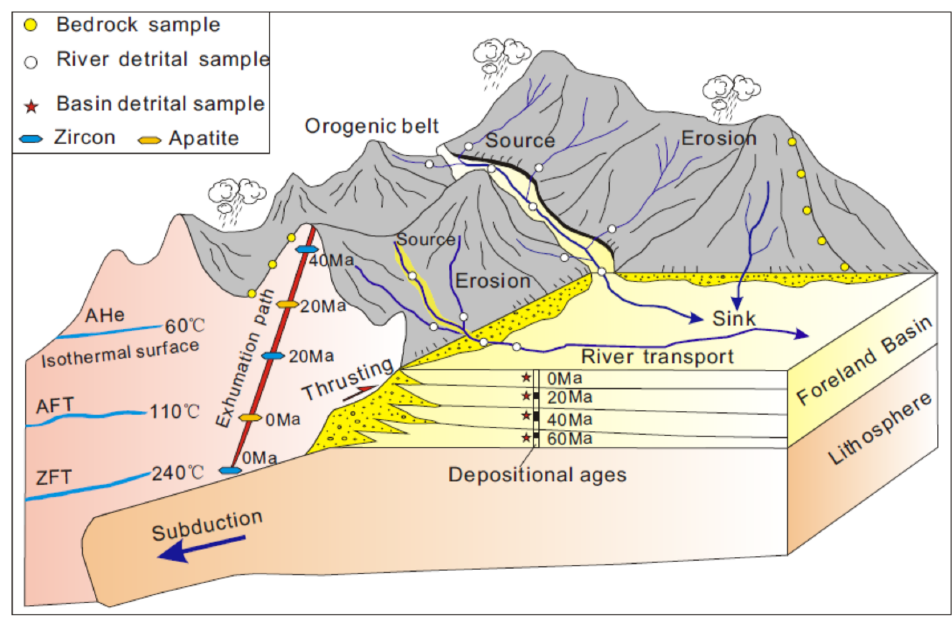
Figure 2. Cartoon showing the source-to-sink relationship between bedrock erosion and fore- land deposition. The exhumation path can be restored by either bedrock low-temperature ther- mochronology data (AHe, AFT, and ZFT) from the orogen or detrital data from the foreland basin and river